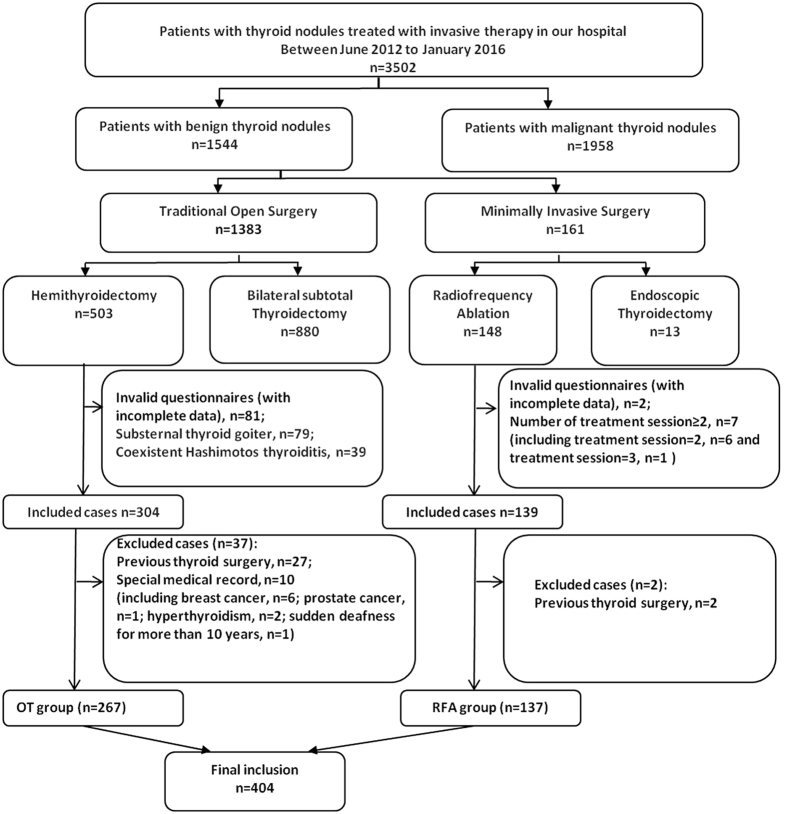
Flow chart for the management of thyroid nodules in our hospital.RFA group, patients treated with radiofrequency ablation; OT group, patients treated with open thyroidectomy.